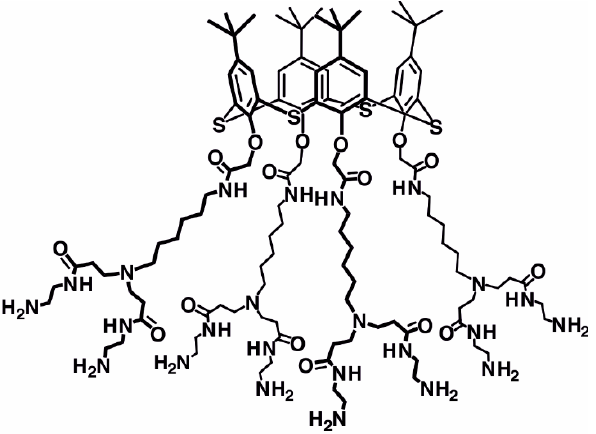
Figure 1. Chemical structure of the substituted thiacalix[4]arene TC bearing eight terminal amino groups used in the work for DNA sensing.